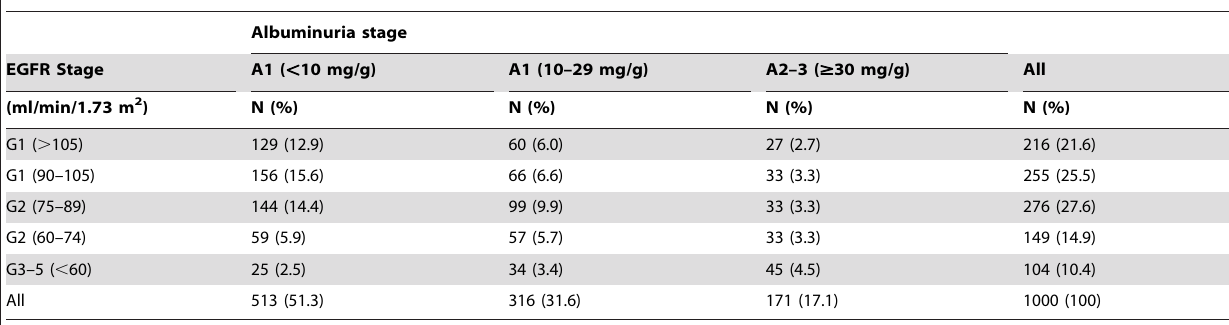
Table 3. Chronic kidney disease stages, as proposed in the KDIGO classification.